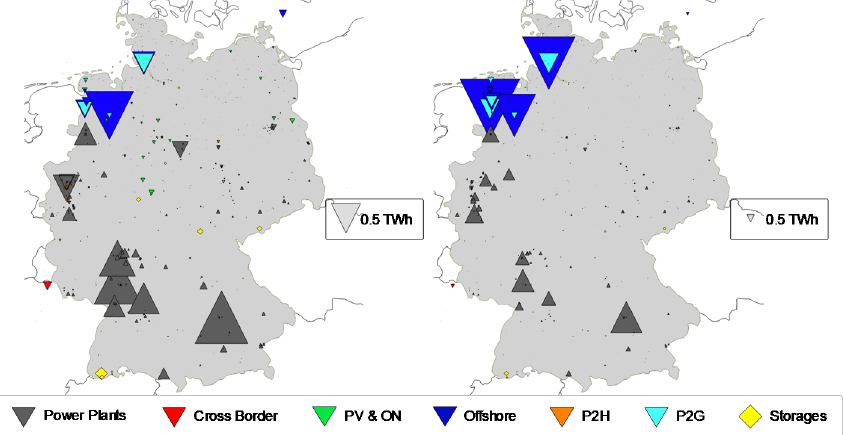
Figure 18. Distribution of redispatch and feed-in management: ( left ) picture shows reference scenario 2035, and ( right ) picture shows the sensitivity with increased offshore wind. A downward triangle indicates an increased operation of power-to-gas (P2G) or power-to-heat (P2H) units, whereby electrical energy is ejected from the electrical transmission grid.